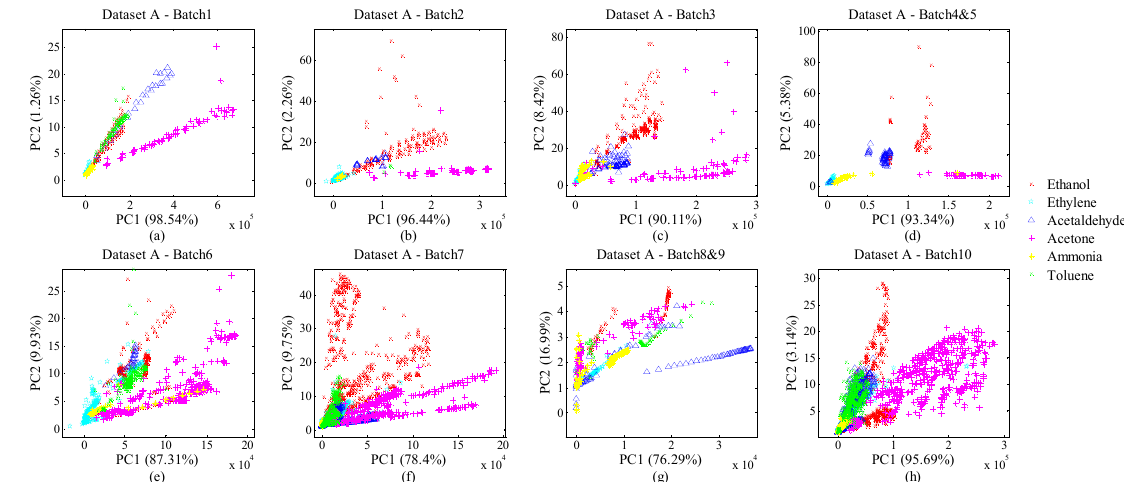
Figure 2. ( a ) Data distribution of Batch 1. ( b ) Data distribution of Batch 2. ( c ) Data distribution of Batch 3. ( d ) Data distribution of Batch 4&5. ( e ) Data distribution of Batch 6. ( f ) Data distribution of Batch 7. ( g ) Data distribution of Batch 8&9. ( h ) Data distribution of Batch 10.